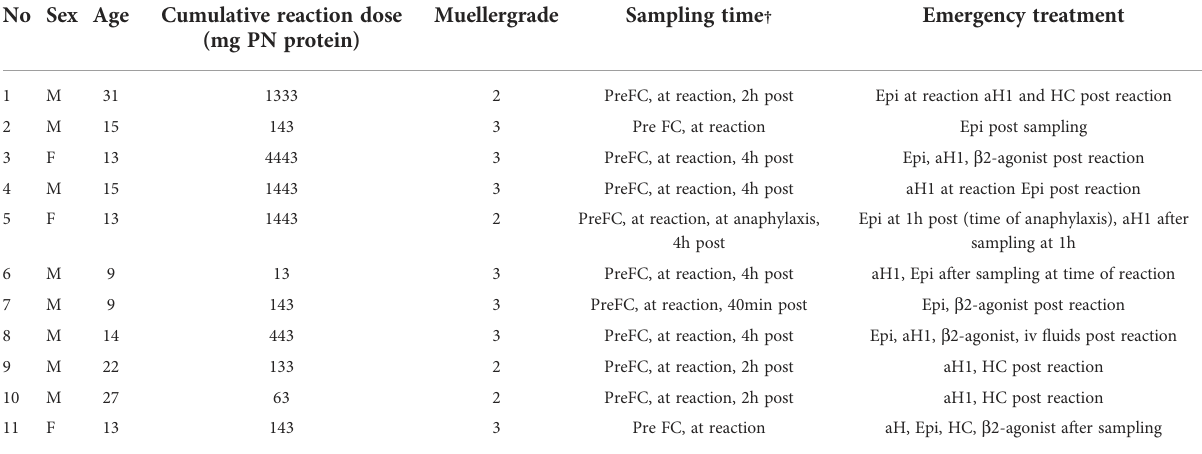
TABLE 2 Patients with peanut allergy undergoing double-blind placebo-controlled food challenge to peanut. No Sex